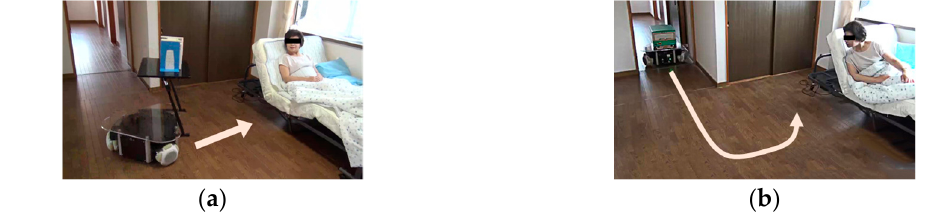
Figure 2. Usage examples of the indoor carrier robot: ( a ) Carrying books; ( b ) Carrying a